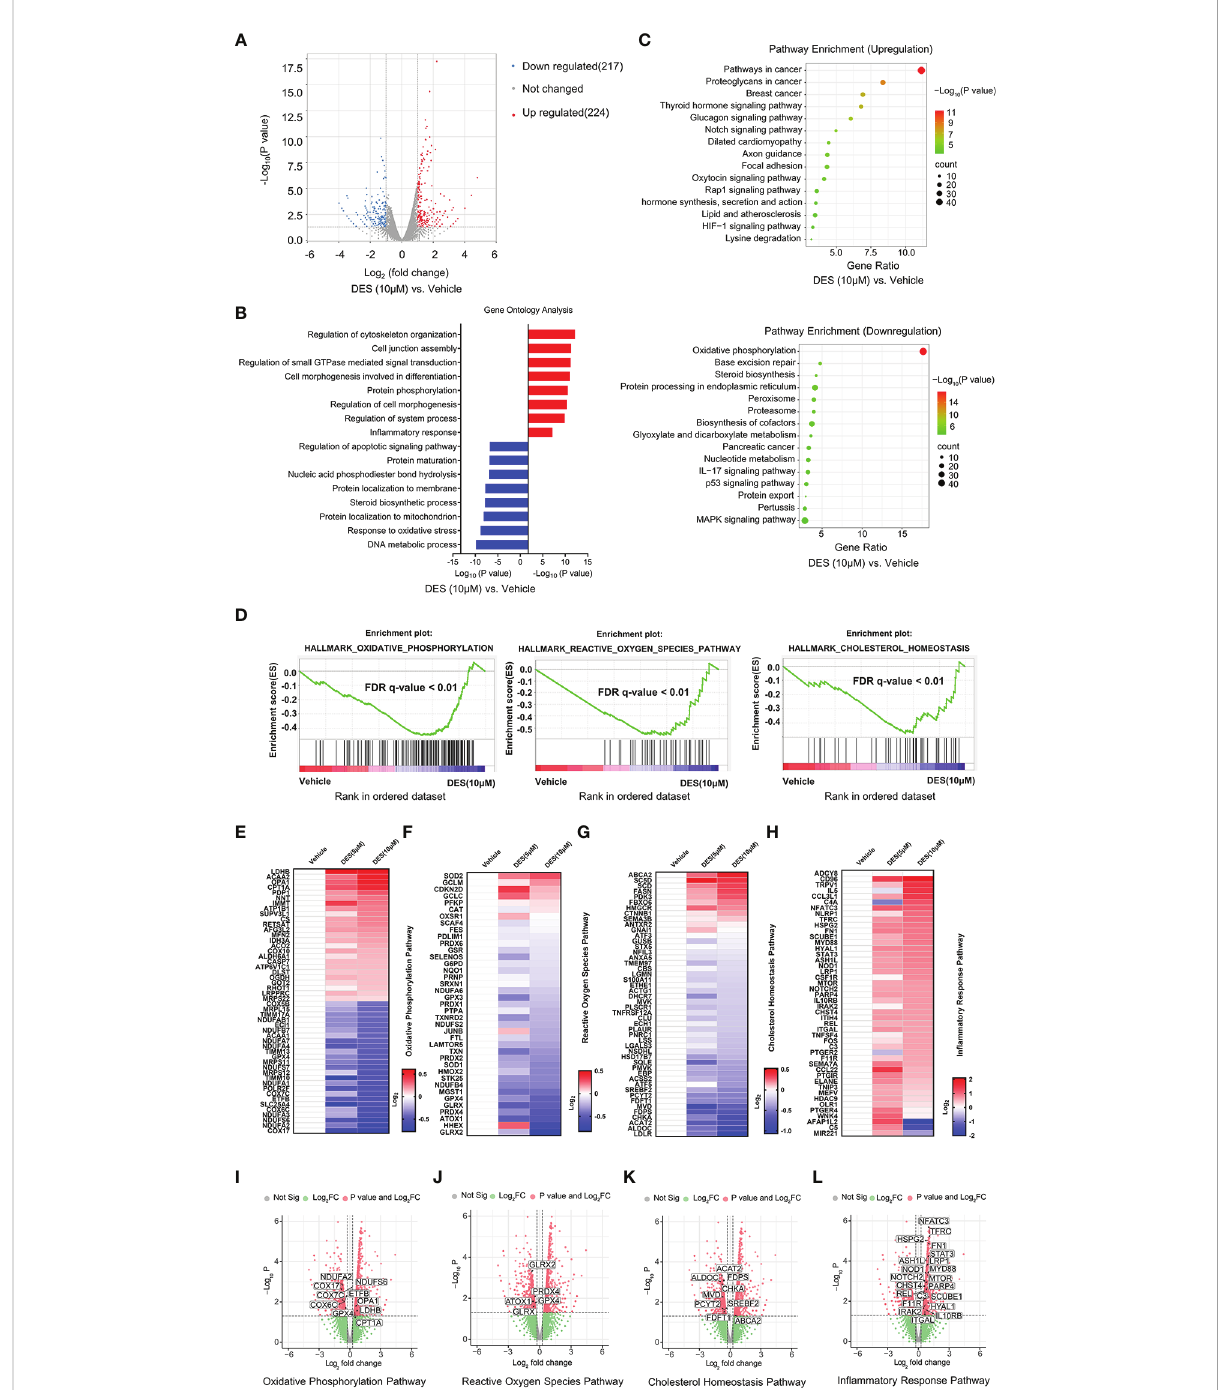
FIGURE 2 DES drives in fl ammatory response and alleviates oxidative stress pathways in IPI-2I cells. (A) Volcano plot visualization of the differential gene expression pro fi les between the DES (10 m M) and vehicle group by transcriptome analysis. (B) Genes expression involved in the in fl ammatory response pathway were among the most enriched pathways analyzed by GO. (C) DEGs involved in the OXPHOS pathway were the most abundant downregulated enrichments analyzed by the KEGG. (D) The GSEA depicting the enrichment of DEGs downregulated in the cholesterol homeostasis, OXPHOS, and ROS pathways from DES (10 m M) versus vehicle in IPI-2I. FDR, false-discovery rate. (E – H) Heatmaps of mRNA expression (RNA-seq, Log 2 transformed) changes of the aforementioned (B – D) pathways. (I – L) Volcano plot visualization of DEGs in the aforementioned (B – D) pathways from DES (10 m M) versus vehicle in